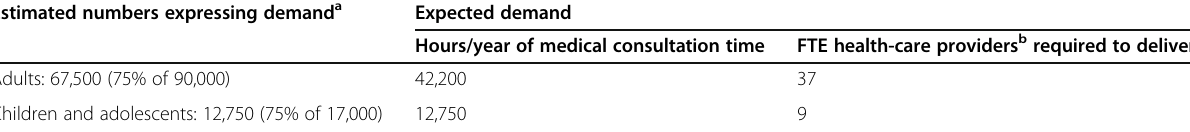
Table 2 Estimated service requirements to meet headache-related health-care demand in a population of 1 million (from [29]) Estimated numbers expressing demand a Expected